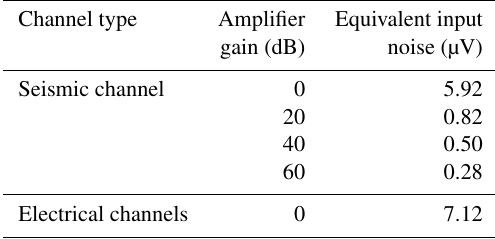
Figure 9. The distribution of the EIN of a data acquisition station. Table 1. Results of EIN